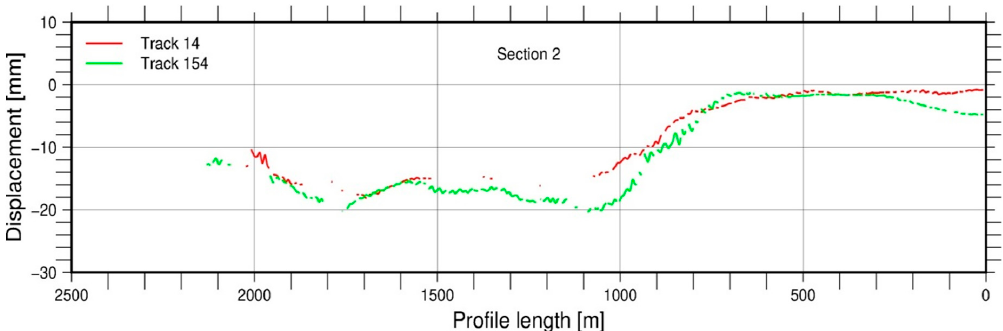
https://www.pgc.umn.edu/data/arcticdem/.